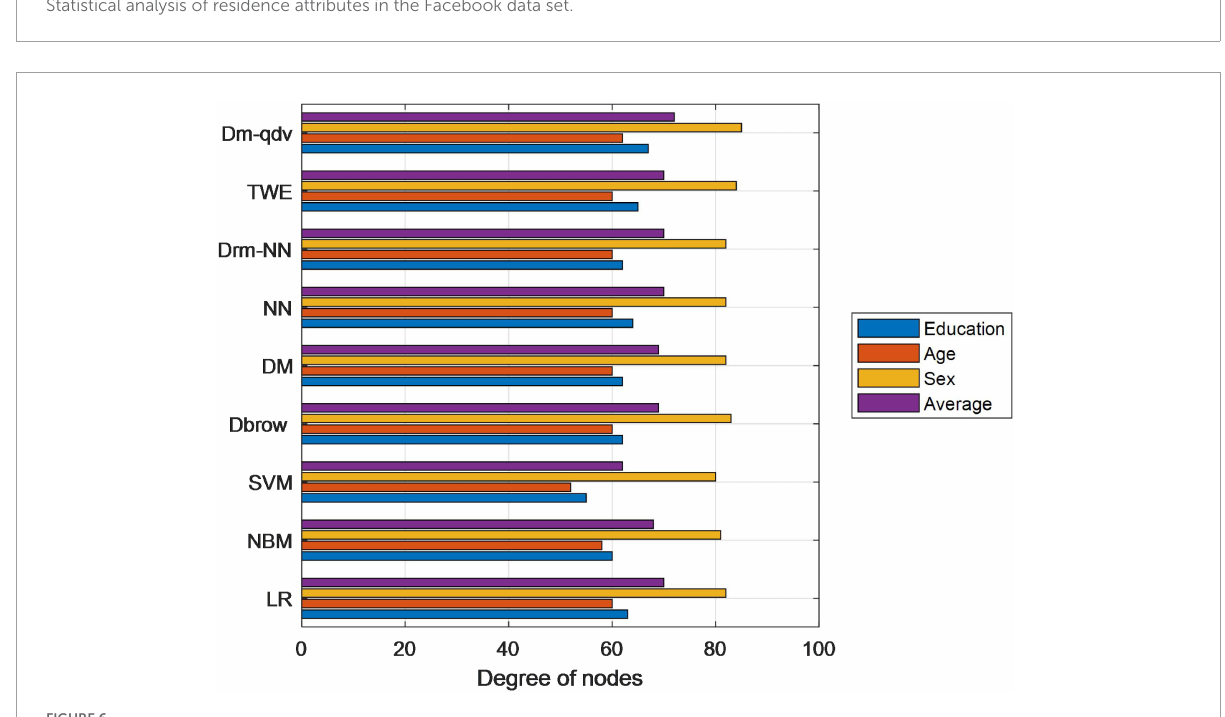
Combined with the advantages of neural network model, the effect of user population attribute prediction task has been further improved. The improved DOC2VEC-QDV model has